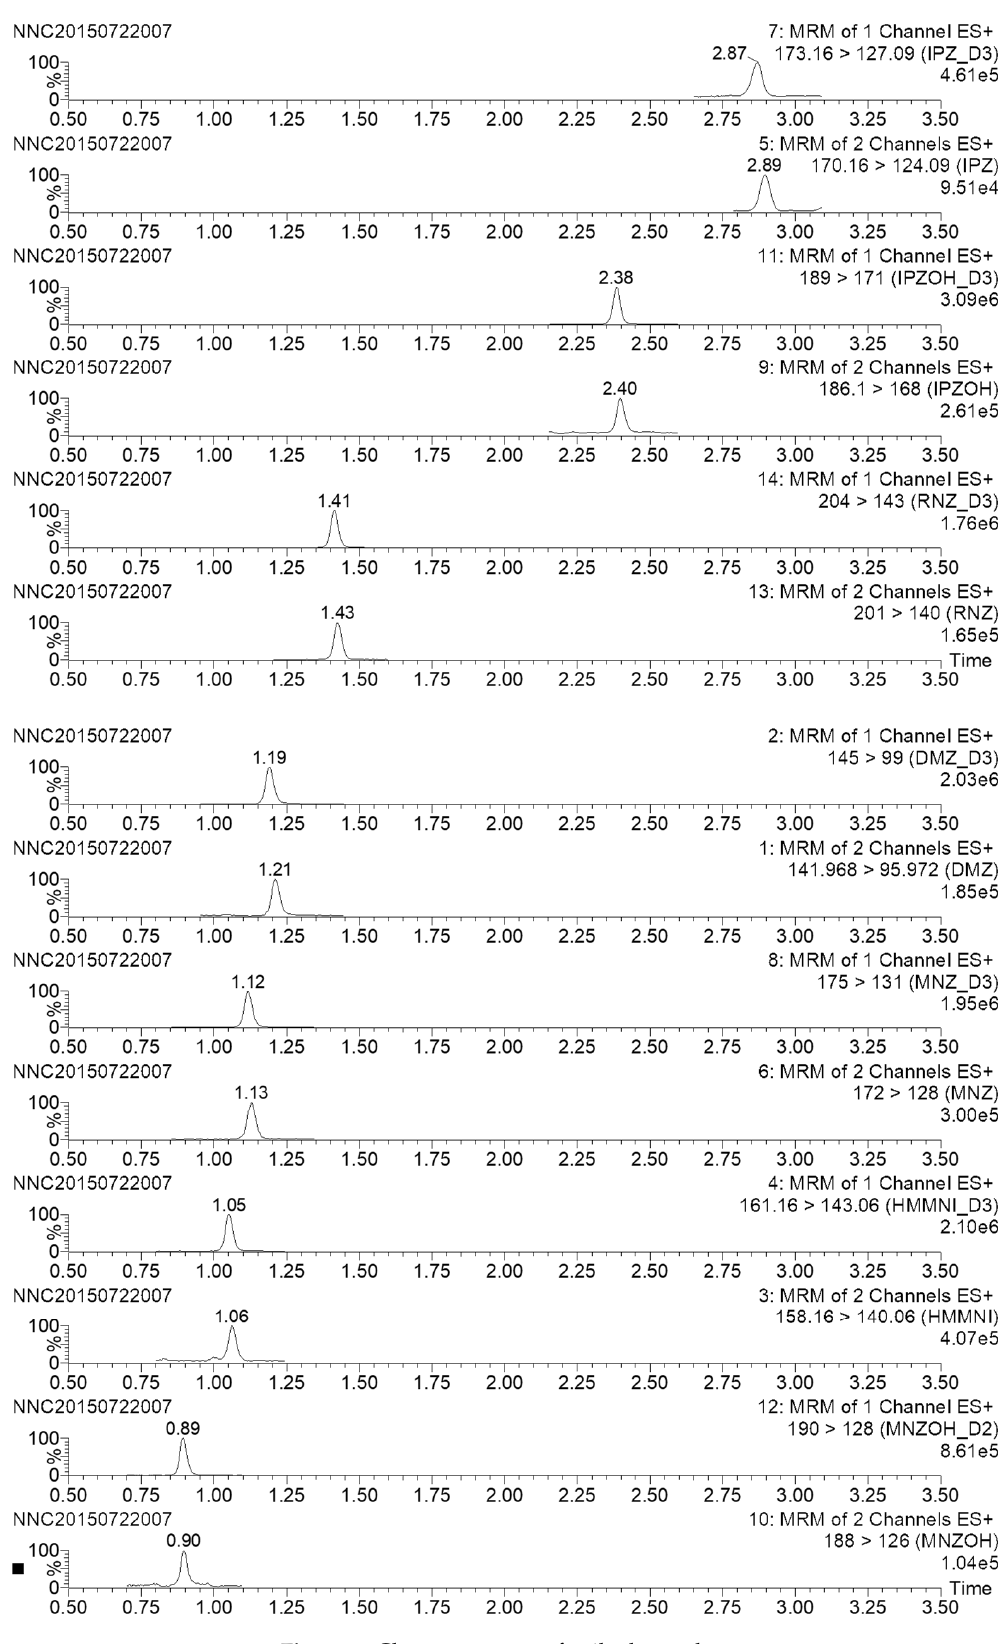
Figure 3. Chromatograms of spiked samples.